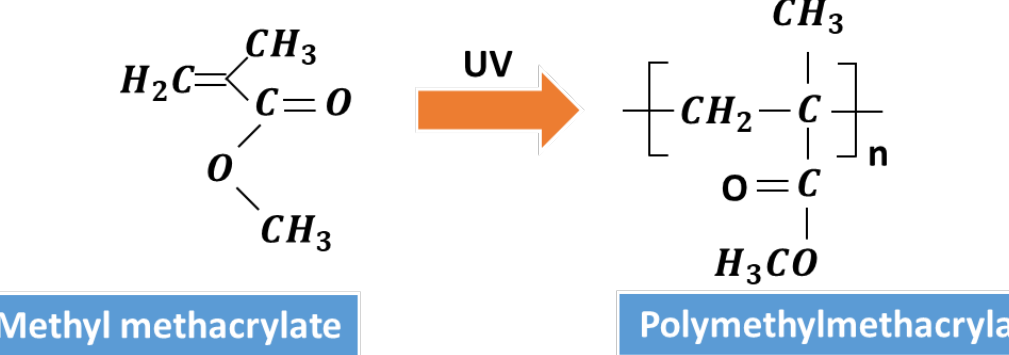
Figure 3. The reaction of UV resin after UV exposure.